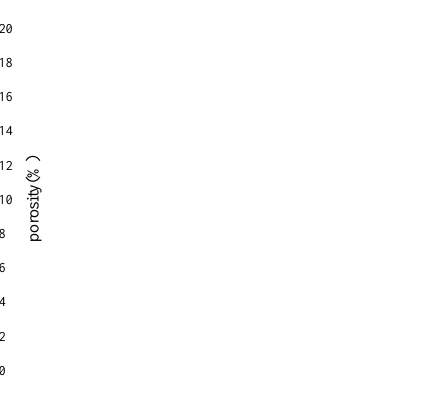
Figure 3. Variation of roughness and porosity of MAO coatings formed with different parameters.